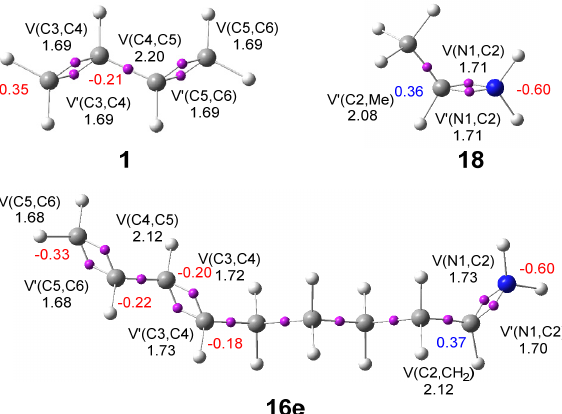
Figure 2. ELF basin attractor positions together with the most relevant valence basin populations, and natural atomic charges, in average number of electrons e, blue color is used for positive charges and red color for negative ones, of butadiene 1 , ethaniminium 18 and dieniminium